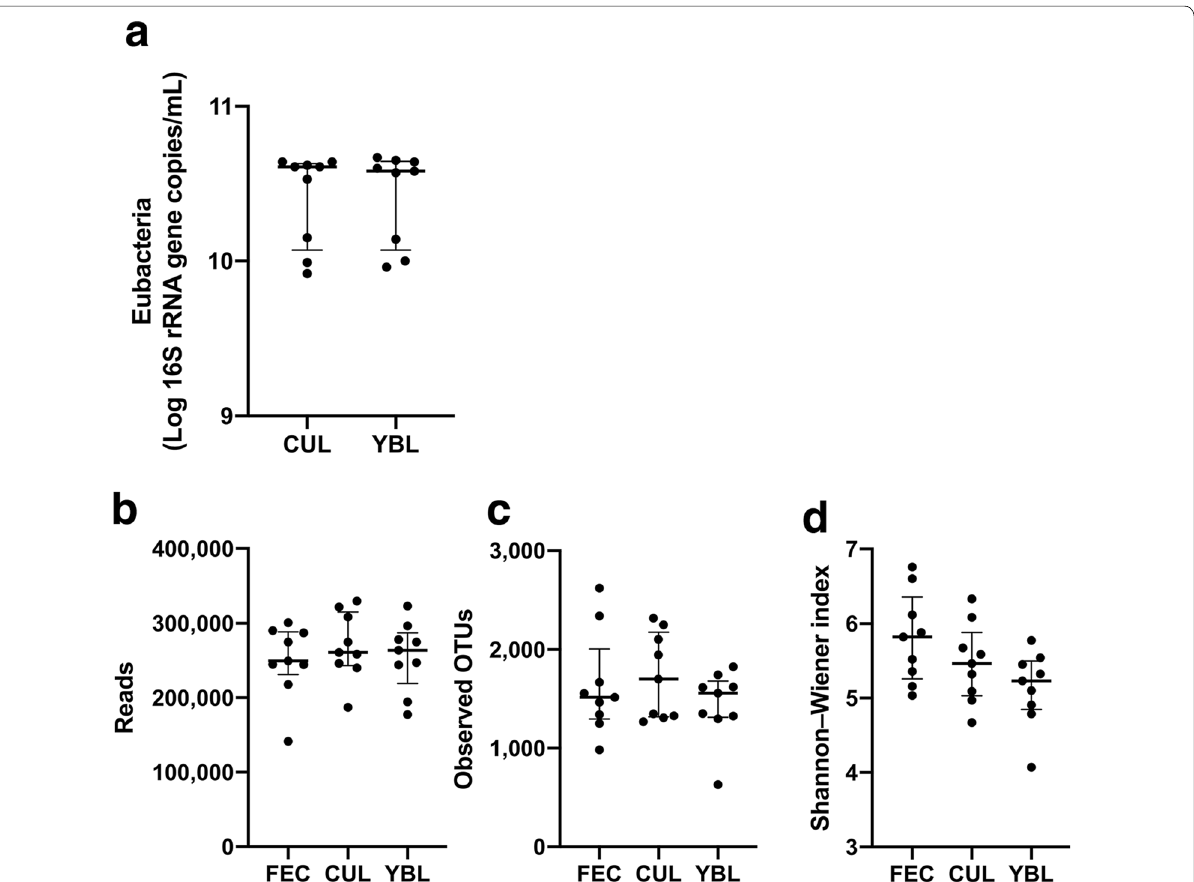
Fig. 1 Summary of 16S rRNA gene data. 16S rRNA genes were amplified using DNA extracted from KUHIMM samples fermented for 48 h without 1.5% YBL (CUL) and with 1.5% YBL (YBL). a Eubacterial copy numbers. b Numbers of quality-controlled sequences obtained by NGS. c Observed numbers of OTUs. d Shannon–Wiener index. The data shown are presented as medians and interquartile ranges (25th–75th